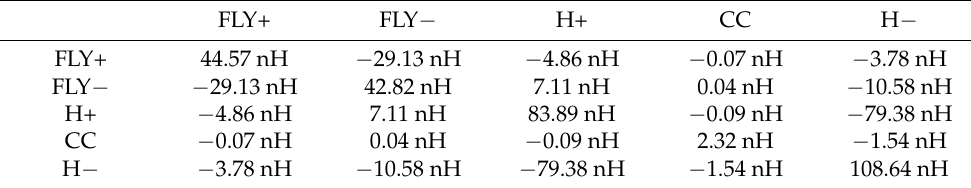
Table 4. The stray self-inductance and mutual inductance matrix of the outer bus bar commutation paths. FLY+ FLY − H+ CC